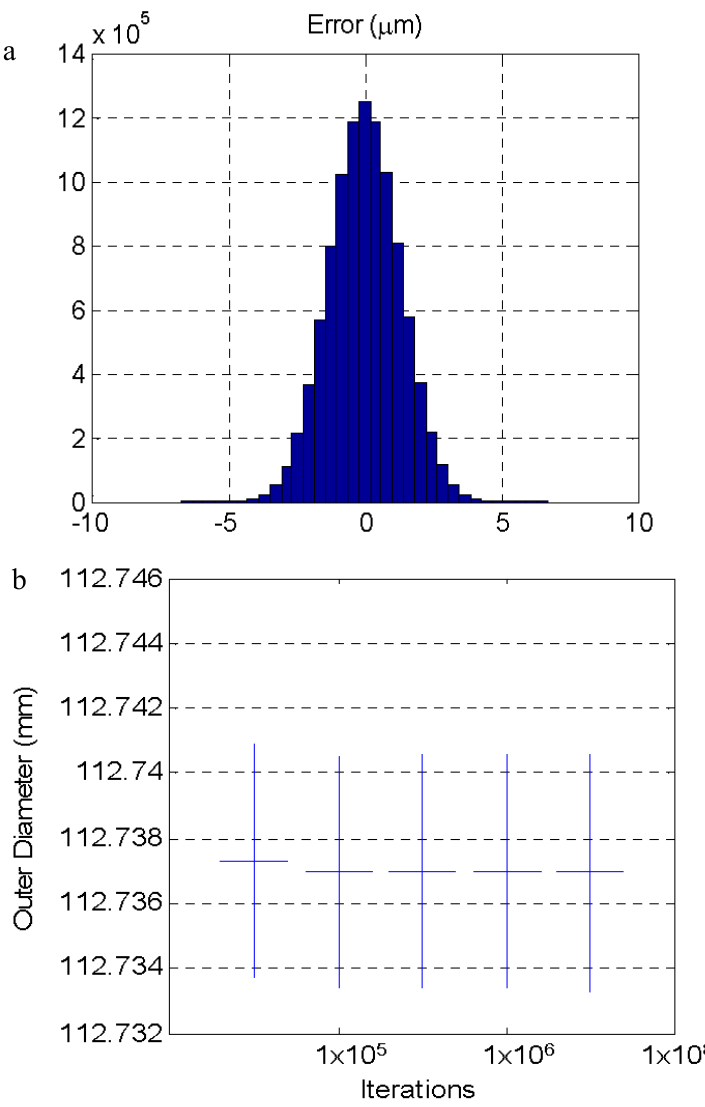
Figure 7. ( a ) Distribution of the error by combining all analyzed parameters with their corresponding distributions. ( b ) Convergence of the result of the simulation.